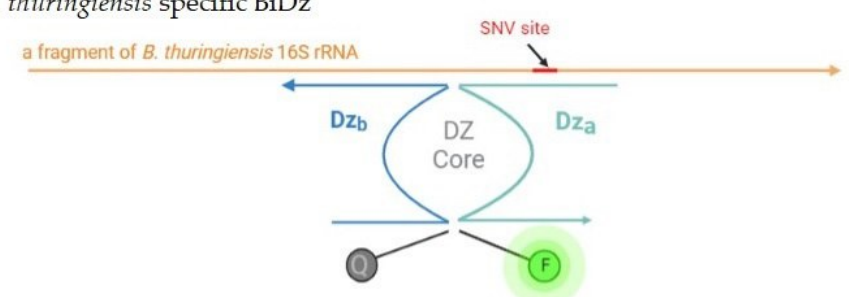
Figure 1. Design of BiDz probes used in this study. Design of B. thuringiensis –specific BiDz probe. DNA strand Dz a and Dz b bind RNA analyte and form a catalytic core that cleaves fluorophore and quencher labelled F-sub. The design of B. mycoides –specific BiDz probe differs from the design of B. thuringiensis –specific BiDz probe in the reporter substrate used. The Cy-sub reporter substrate was used with the B. mycoides –specific BiDz probe. The difference between F-sub and Cy-sub sequence is shown in Table S1.